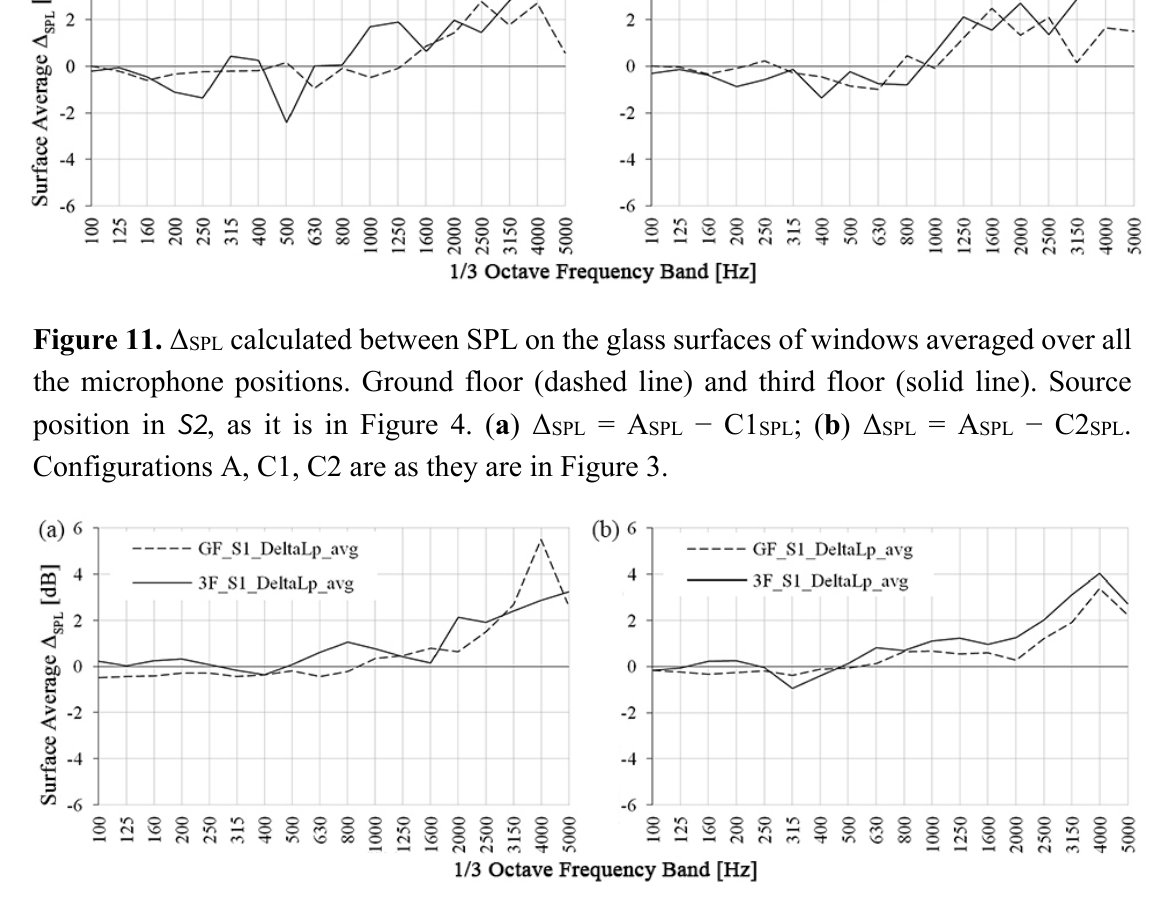
Figure 12. Δ SPL calculated between SPL on the glass surfaces of windows averaged over all the microphone positions. Ground floor (dashed line) and third floor (solid line). Source position in S1 , as it is in Figure 4. ( a ) Δ SPL = B1 SPL − C1 SPL ; ( b ) Δ SPL = B2 SPL − C2 SPL . Configurations B1, B2, C1, C2 are as they are in Figure